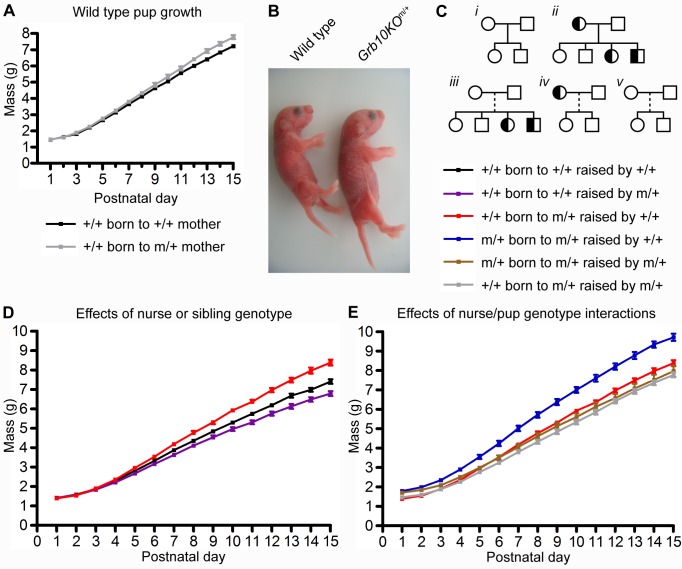

Grb10 controls postnatal supply and demand.(A) WT (+/+) pups born to Grb10KO
m/+ (m/+) dams gained more weight to postnatal day 15 than WT pups born to WT dams. (B) Grb10KO
m/+ and WT male siblings on the day of birth. (C) Schematic of dam/pup relationships studied. All crosses used WT sires (white squares). WT dams (white circles) gave birth only to WT pups (i), while Grb10KO
m/+ dams (half-filled circles) gave birth to mixed litters of WT and Grb10KO
m/+ pups (ii). Cross-fostering (dashed line) enabled switching of dam/pup genotypes (iii and iv). Pure WT litters were cross-fostered to non-biological WT nurses as a control (v). (D) Effects of nurse or sibling genotype on WT pup growth. (E) Effects of Grb10 genotype interactions between nurse and offspring on pup growth. Values represent means ± standard error.